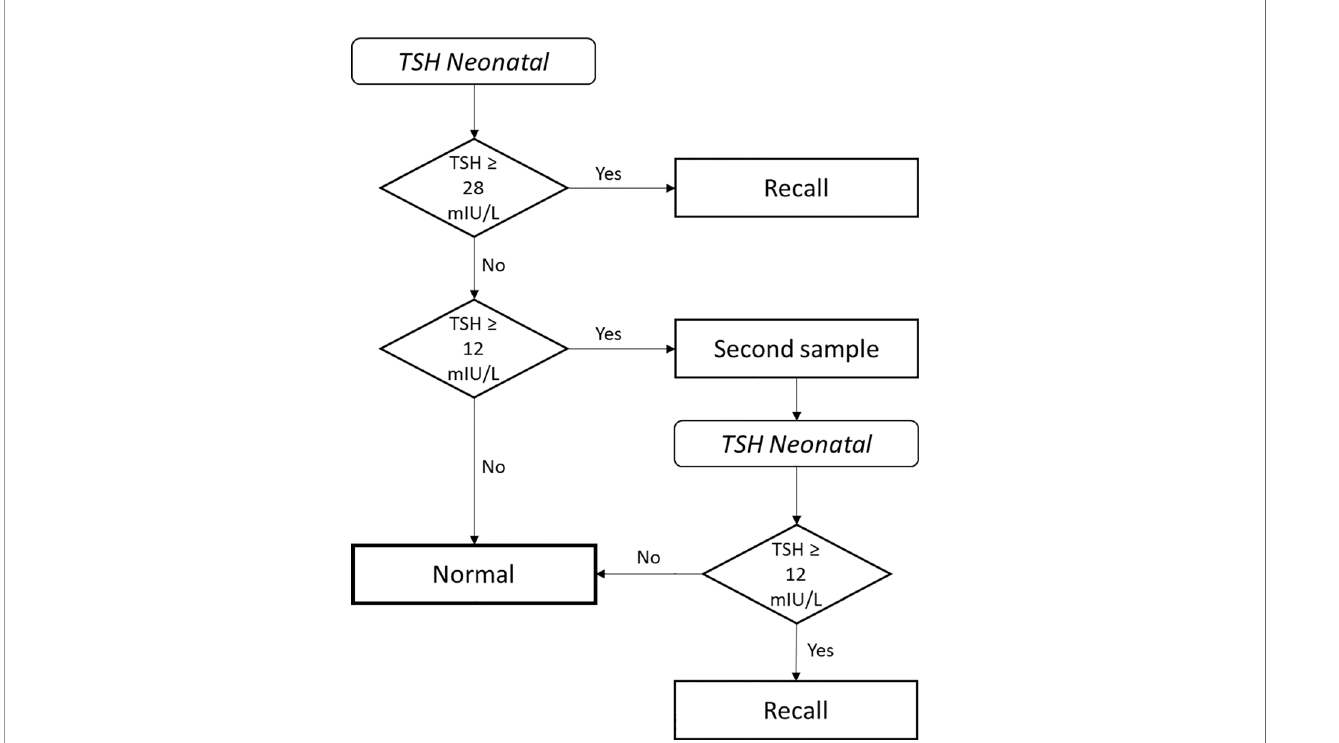
FIGURE 1 | Algorithm for congenital hypothyroidism neonatal screening in